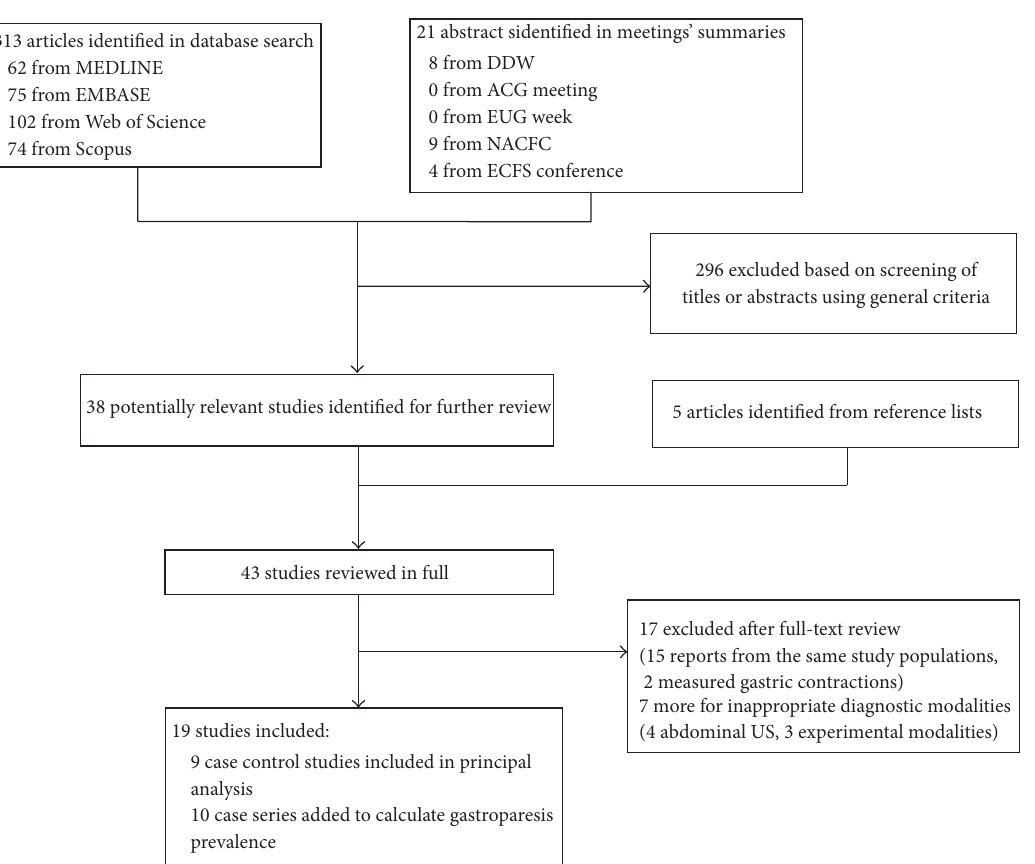
Figure 1: Selection of studies for inclusion in systematic review. DDW: Digestive Disease Week, ACG: American College of Gastroenterology, EUG: United European Gastroenterology, NACFC: North American Cystic Fibrosis Conference, and ECFS: European Cystic Fibrosis